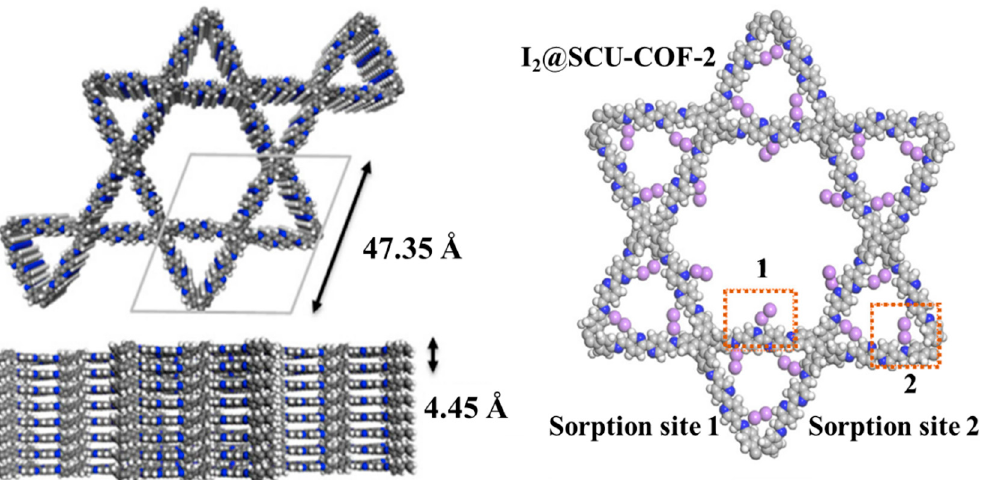
Figure 11. Left : top view and side view of SCU-COF-2. Right : adsorption of I 2 on SCU-COF-2. Reprinted/adapted with permission from Ref. [69]. Copyright (2021), Elsevier.